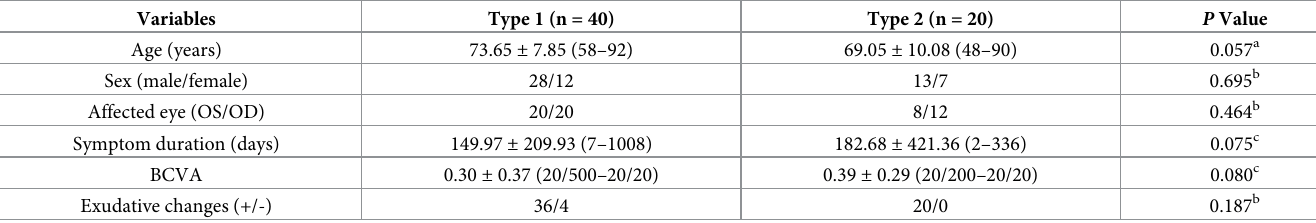
Table 1. Patients’ demographics and